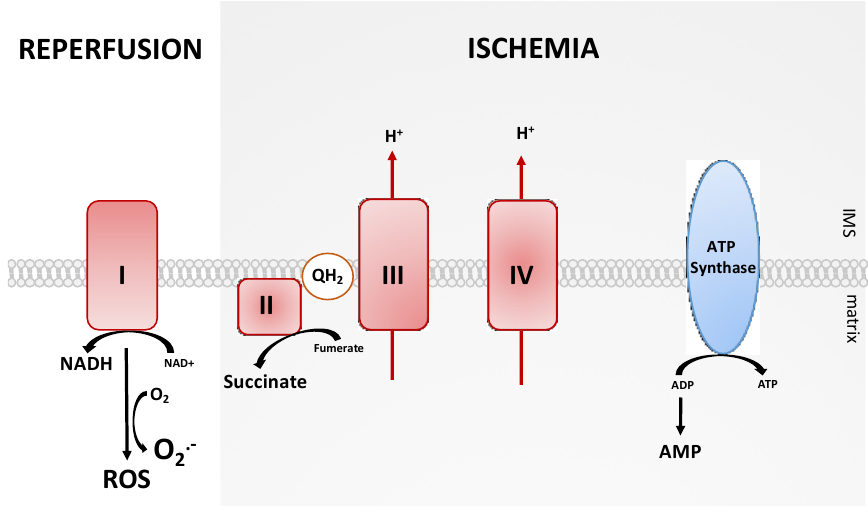
Figure 2. The mitochondrial reverse electron transport (RET) as the main source of reactive oxygen species (ROS) production during ischemia and reperfusion. NAD/NADH: nicotinamide adenine dinucleotide, ADP: adenosine diphosphate, ATP: adenosine triphosphate, IMS: intermembrane space.